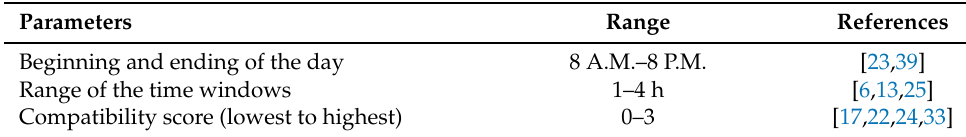
Table 2. Range of non-editable parameters for